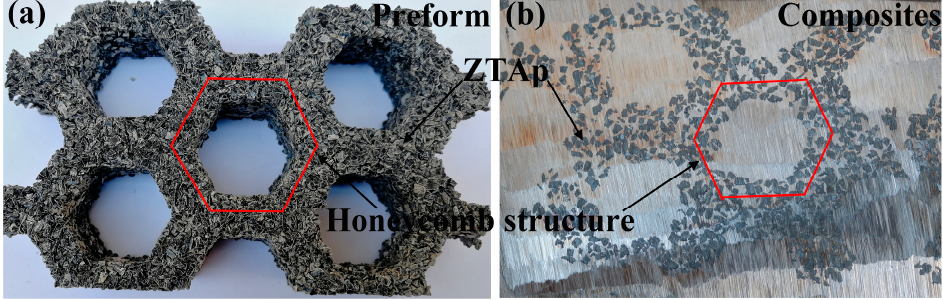
Figure 1. The preform ( a ) and the composites with honeycomb structure ( b ).